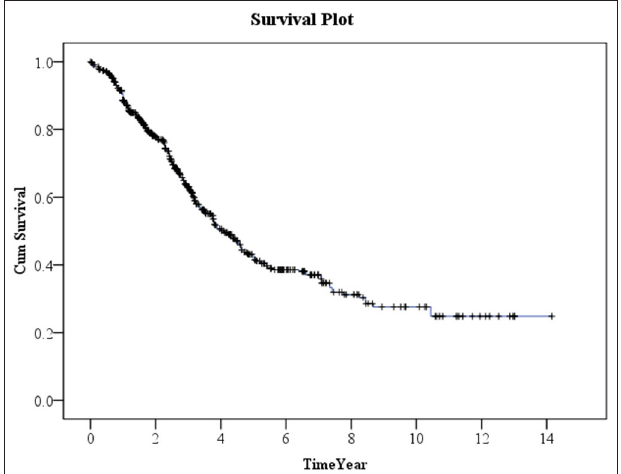
FIGURE 3 | The survival pot of PD catheter in patients with and without diabetes. PD, peritoneal dialysis.